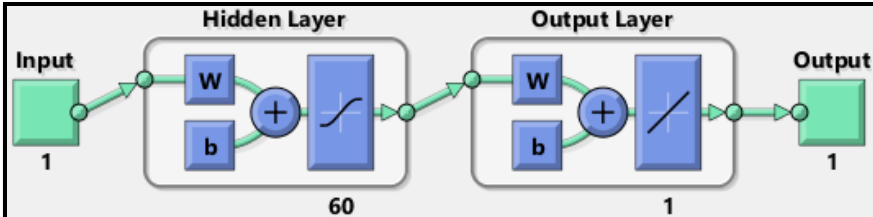
Figure 4. The feed-forward structure of the neural network used supervised learning of the targeted data on micro-polar fluids.